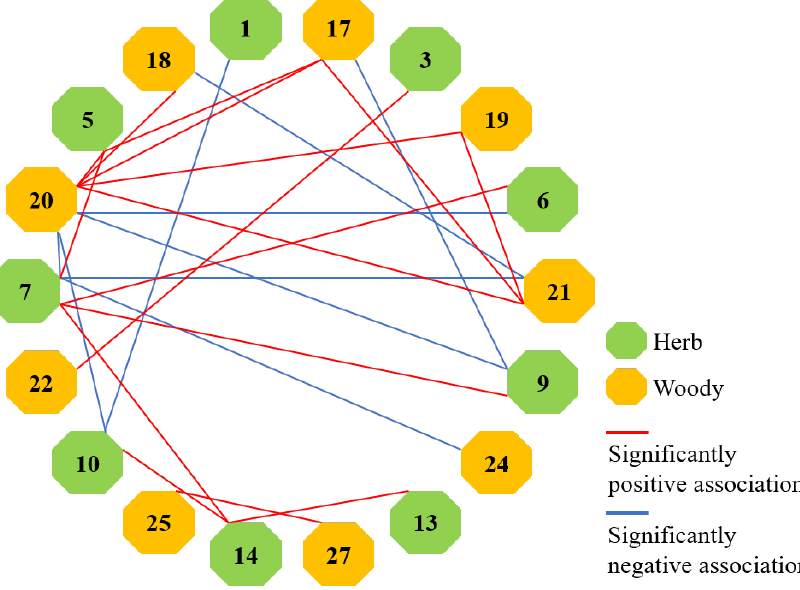
Table 3. Overall association of the 30 dominant species at the Ziwuling study area on the Chinese Loess Plateau.